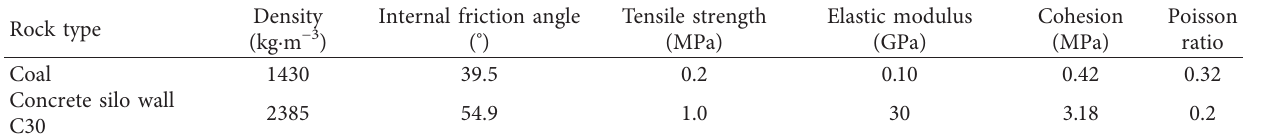
Figure 3: Numerical model of the shaft wall. Table 1: Physical and mechanical parameters of rock mass used in numerical